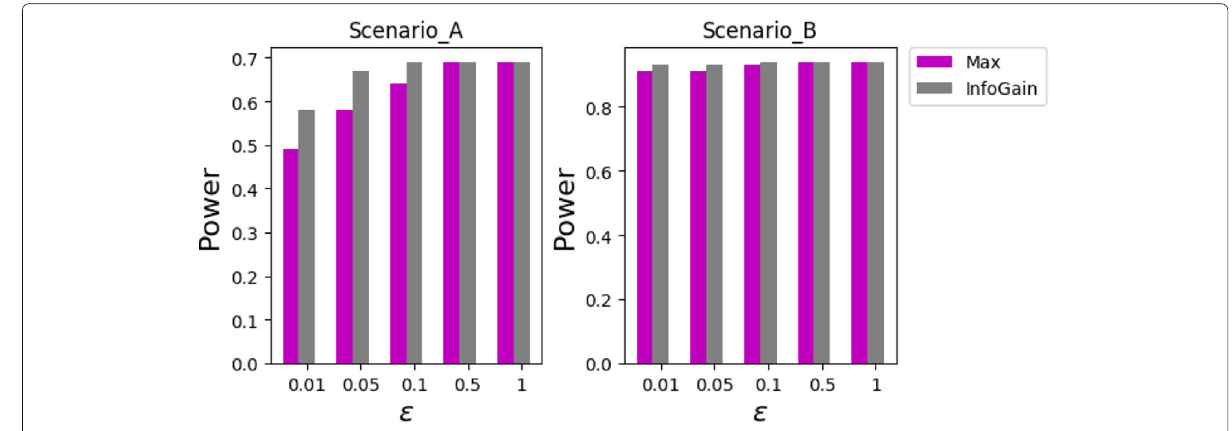
Fig. 5 050301_2( MAF = 0.5, λ = 0.3, r 2 = 1), L =